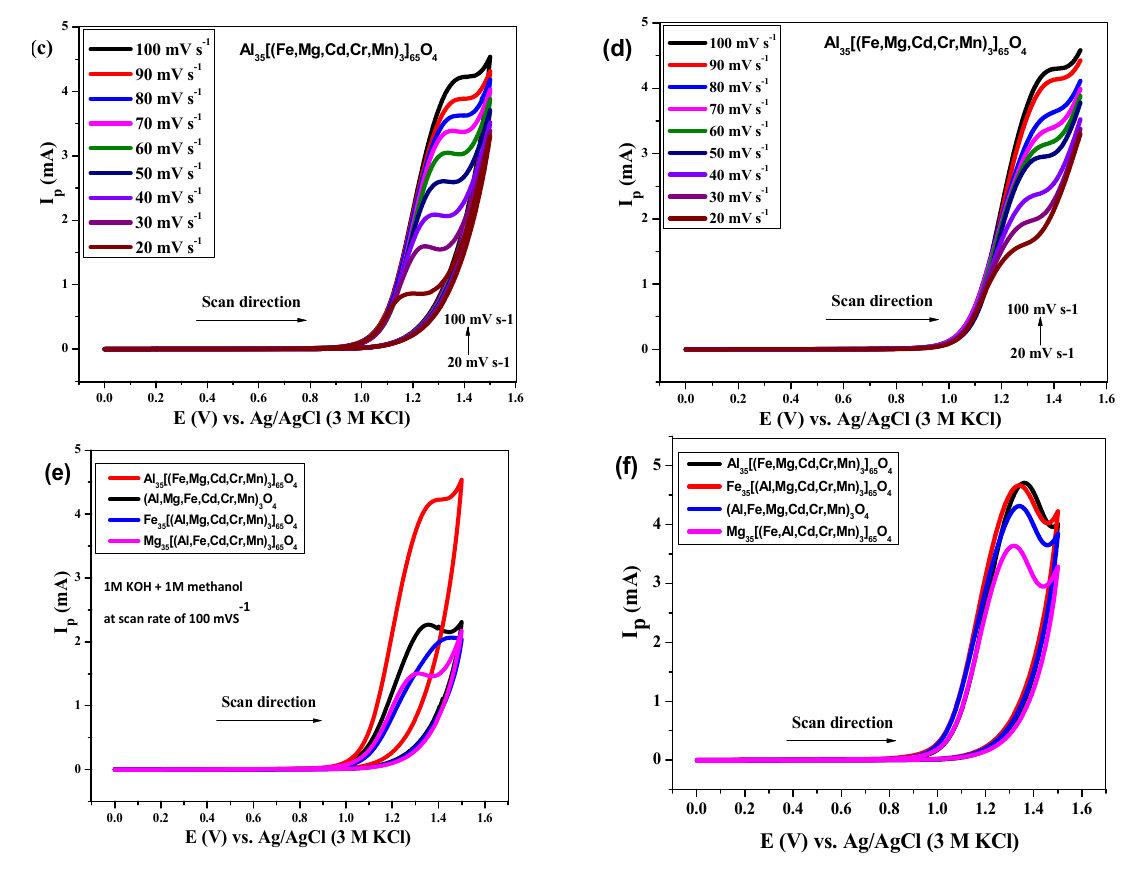
Figure 5. Cyclic voltammetry using [Fe 35 (Al, Mg, Cd, Cr, Mn) 3 ) 65 ]O 4 ( a ), [Mg 35 (Al, Fe, Cd, Cr, Mn) 3 ) 65 ]O 4 ( b ), [Al 35 (Fe, Mg, Cd, Cr, Mn) 3 ) 65 ]O 4 ( c ), LSV for [Al 35 (Fe, Mg, Cd, Cr, Mn) 3 ) 65 ]O 4 ( d ), comparison of [(Al, Fe, Mg, Cd, Cr, Mn) x ] 3 O 4 ( e ) and comparison of [(Al, Fe, Mg, Cu, Ni, Co) x ] 3 O 4 ( f ) HEOs in 1M KOH + 1M CH 3 OH.